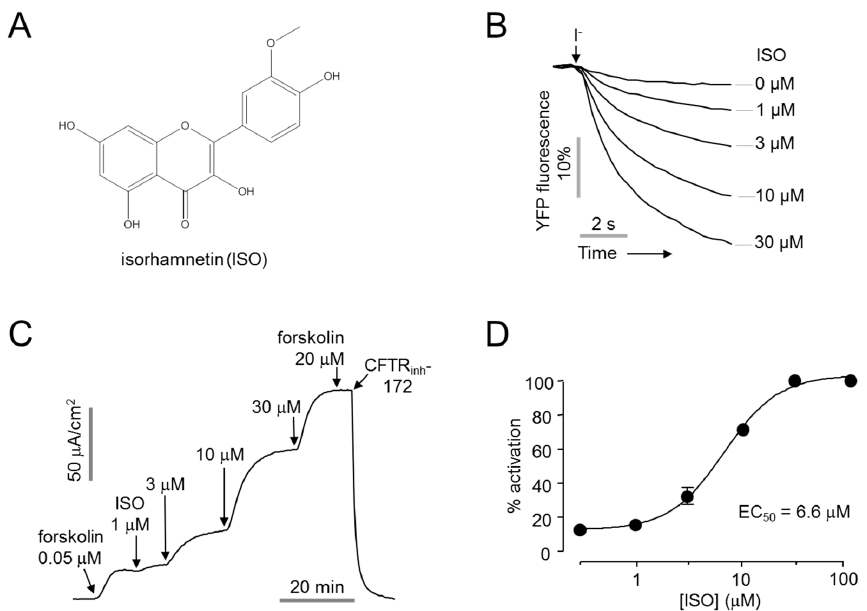
Figure 1. Identification of novel CFTR activator, isorhamnetin. ( A ) Chemical structure of isorhamnetin ( B ) YFP fluorescence measured in CHO-K1 cells expressing CFTR and YFP-F46L/H148Q/I152L. Indicated concentrations of isorhamnetin were applied 10 min prior to extracellular I - addition. ( C ) Apical membrane current measured in WT-CFTR expressing FRT cells. CFTR was activated by indicated concentrations of isorhamnetin and forskolin, CFTR agonist, and inhibited by 10 µ M CFTR inh -172. ( D ) Dose-response curve (mean ± S.E., n = 3–4).